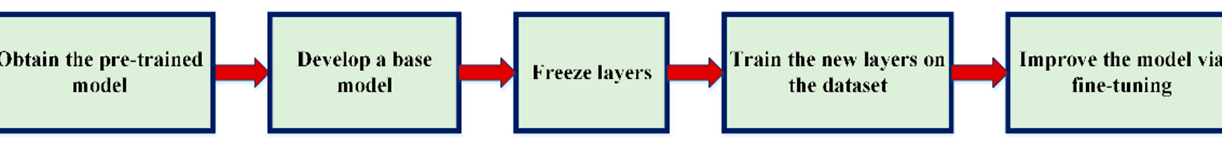
Figure 2. Flowchart of the transfer learning process .